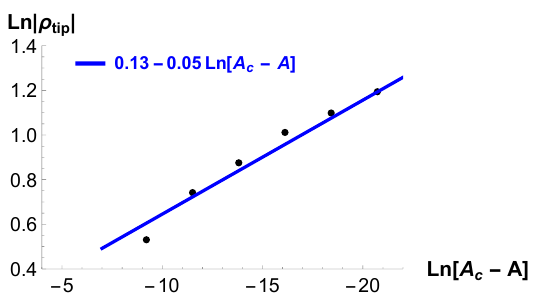
Figure 6 . Depicted is the logarithm of − ρ tip as a function of the logarithm of the deviation from the critical amplitude. The slope of a linear fit is found to be − 0 . 05 ± 0 . 01 . direction, both of which are explicitly reflected in (B.2). Finally, the p R hand side of (B.5) is a stringy dressing of the graviton one point function in spacetime, required for the appropriate map from the graviton condensate 8 in the exact worldsheet CFT, to the ST geometry variables.